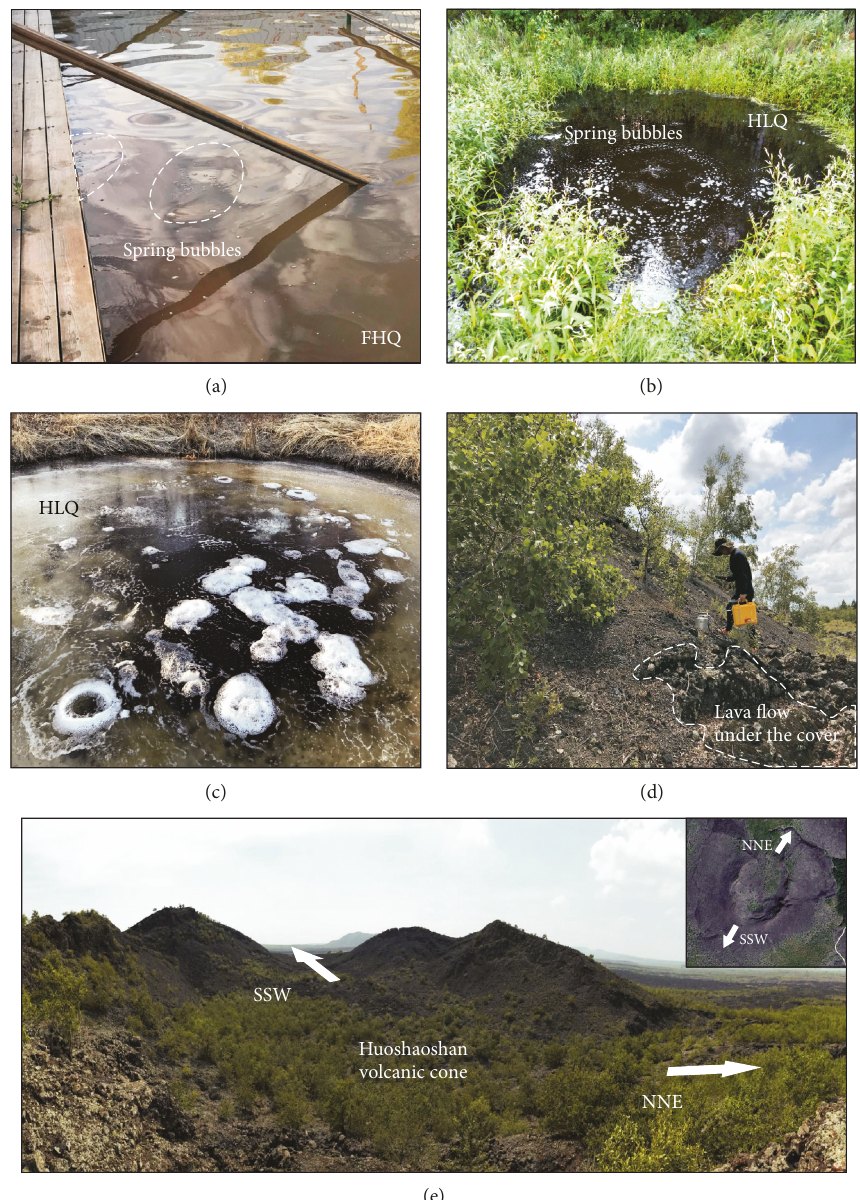
Figure 2: Photos showing the Fanhua spring (a), Hualin spring in August 2017 (b) and April 2019 (c), basaltic lava fl ow under the thin pumiceous deposits beside the Laoheishan volcanic cone (d), and dominant tectonic weakness direction enlarged by erosion in the Huoshaoshan volcanic cone